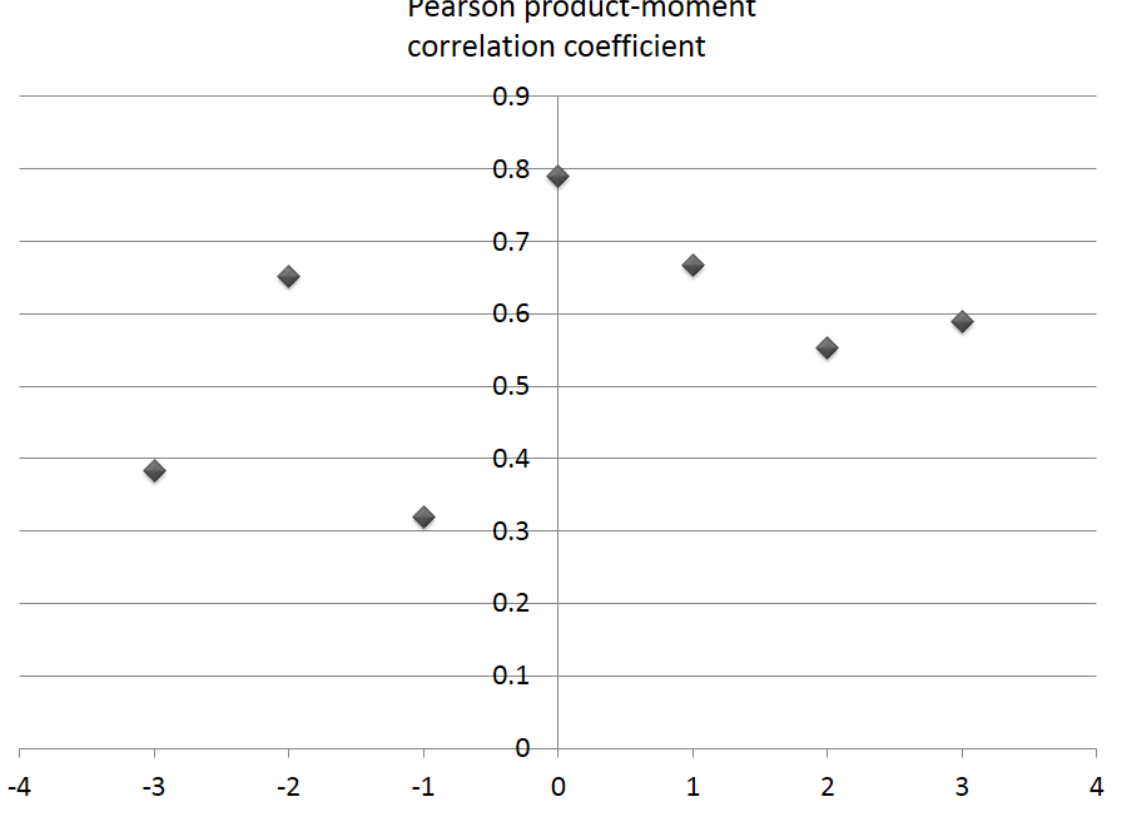
Figure 7. Pearson correlation coefficient between the 2 sequences corresponding to positive keywords in news and negative keywords on the Web, with staggering the sequences by sliding time